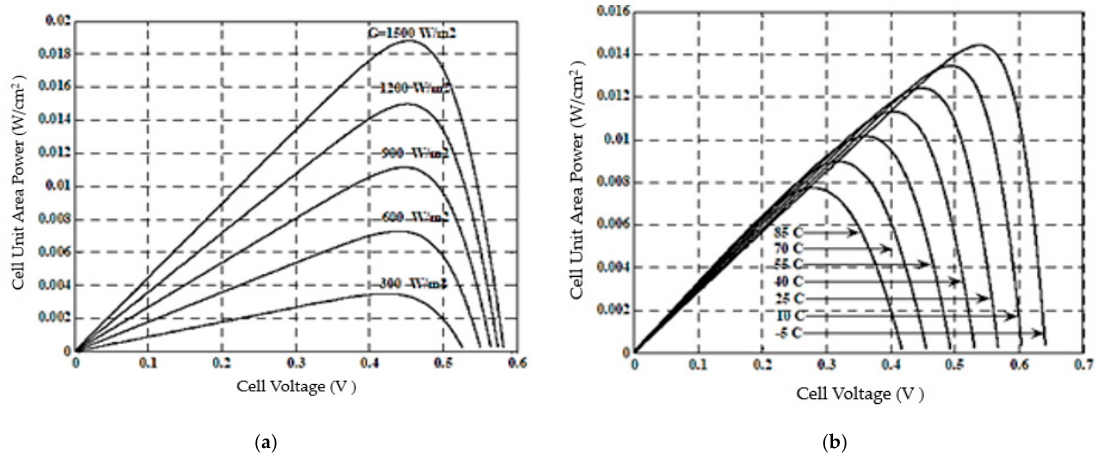
Figure 4. Effects of ( a ) solar radiation in constant 25 °C and ( b ) air temperature shift in constant 1000 W/m 2 radiation on P-V characteristic curve [28].